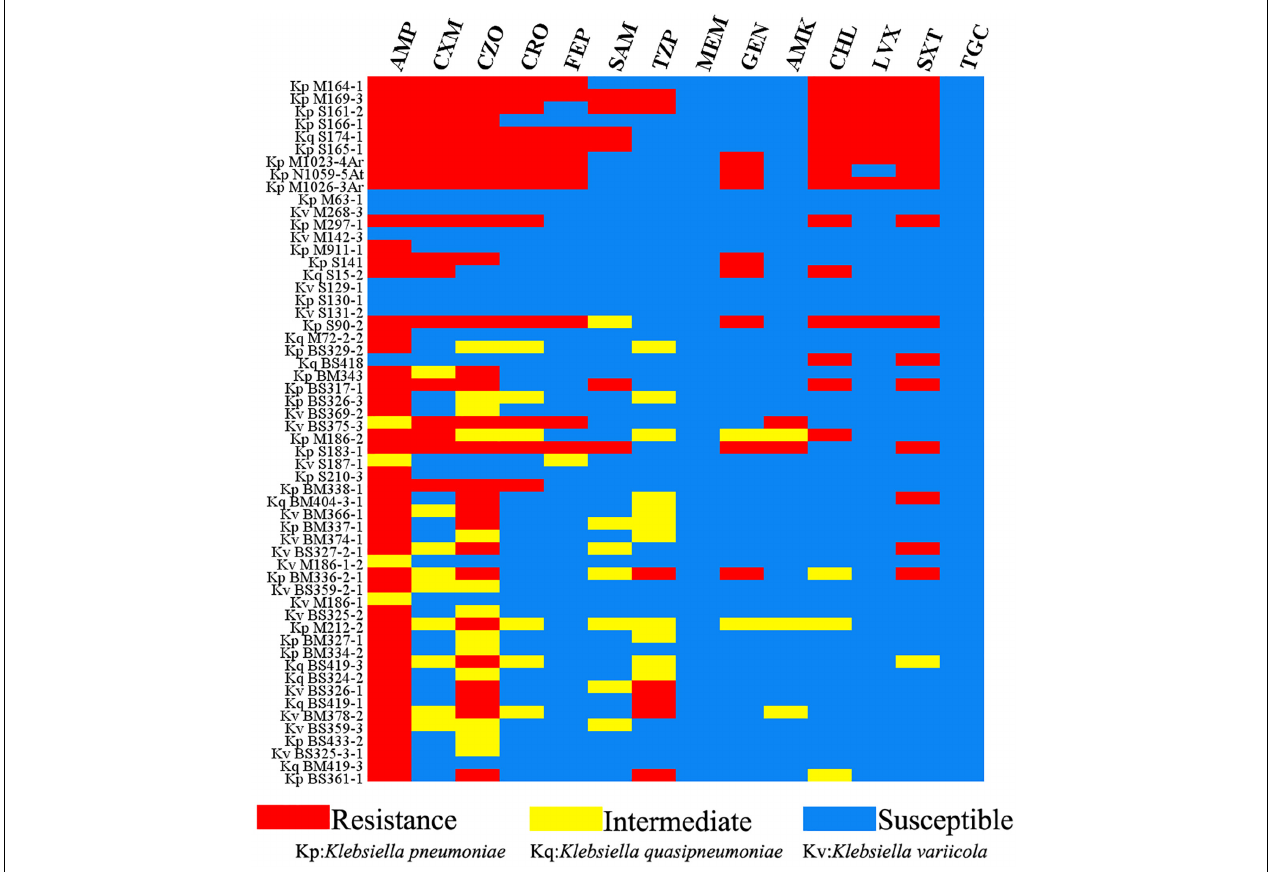
FIGURE 1 | Antimicrobial resistance phenotype of Klebsiella isolates in this study. Red: resistance; yellow: intermediate; blue: susceptible. AMP, ampicillin; CXM, cefuroxime; CZO, cefazolin; CRO, ceftriaxone; FEP, cefepime; SAM, ampicillin/sulbactam; TZP, piperacillin/tazobactam; MEM, meropenem; GEN, gentamicin; AMK, amikacin; CHL, chloramphenicol; LVX, levofloxacin; SXT, trimethoprim/sulfamethoxazole; TGC,